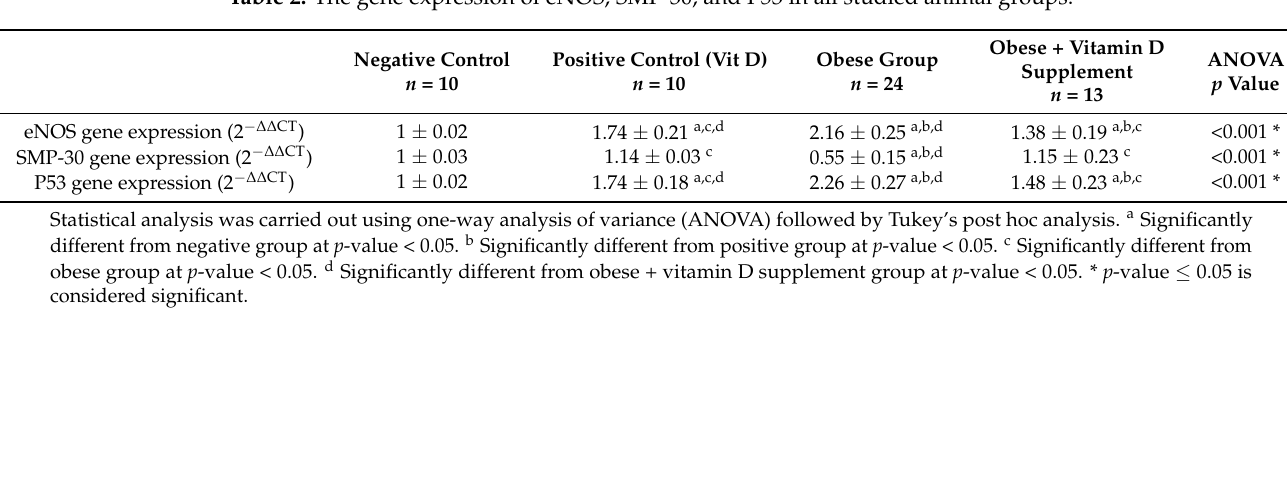
Table 2. The gene expression of eNOS, SMP-30, and P53 in all studied animal